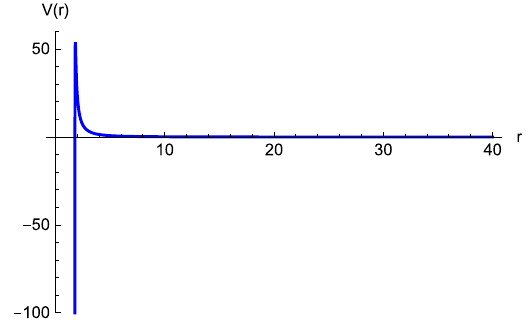
Fig. 1 (Left) potential V ( r ) as function of r with M = 1 , Q = 0 . 6 ,ω = 0 . 02 , a = 0 . 3 , m = 1 , q = 0 . 1 ,λ = 12 ,μ = 0 . 05 for r ∈ [ r + = 1 . 741 , 40 ] . The potential is negatively singular ( − 1 . 324 × 10 13 )